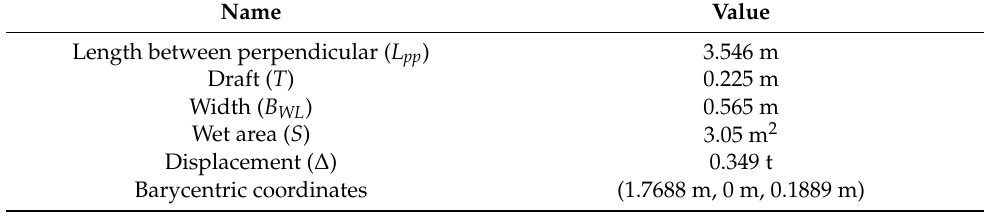
Figure 6. Ship hull mesh. ( a ) Grid of all areas, ( b ) Bow grid, ( c ) Stern grid.